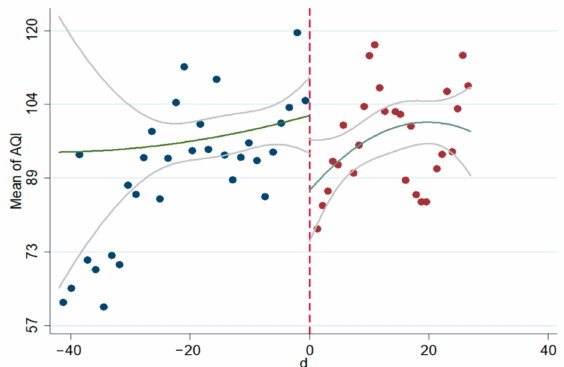
Figure 4. Scatter diagram of AQI before and after the interviews (nonlinear).